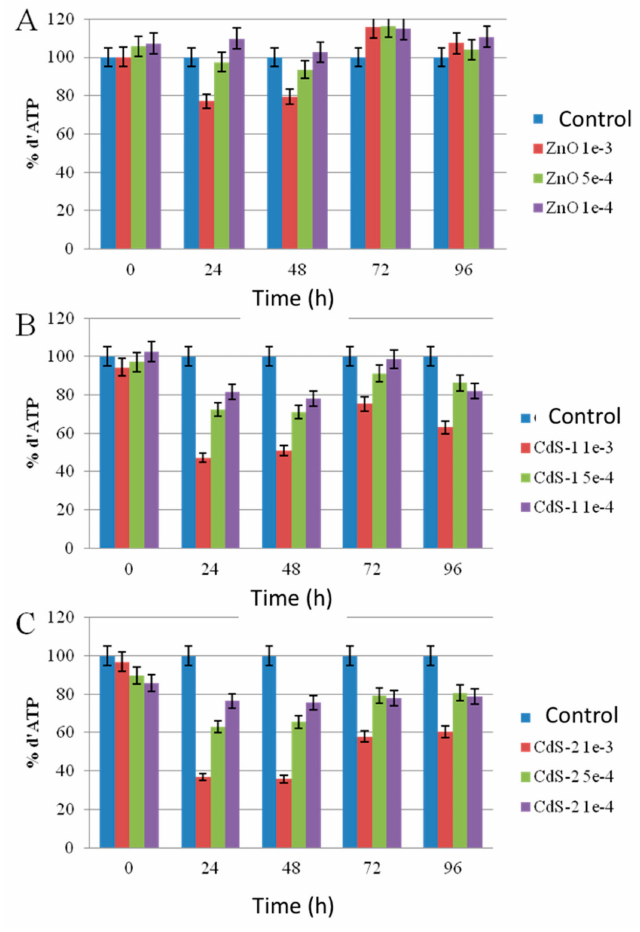
Figure 14. Evolution of the adenosine-5’-triphosphate (ATP) produced by Chlorella vulgaris in the presence of ( A ) ZnO, ( B ) CdS-1, and ( C ) CdS-2 nanoparticles in Seine river water as a function of nanoparticles concentration and